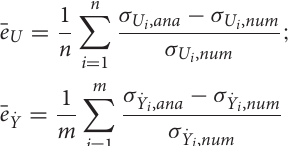
Frontiers in Built Environment |